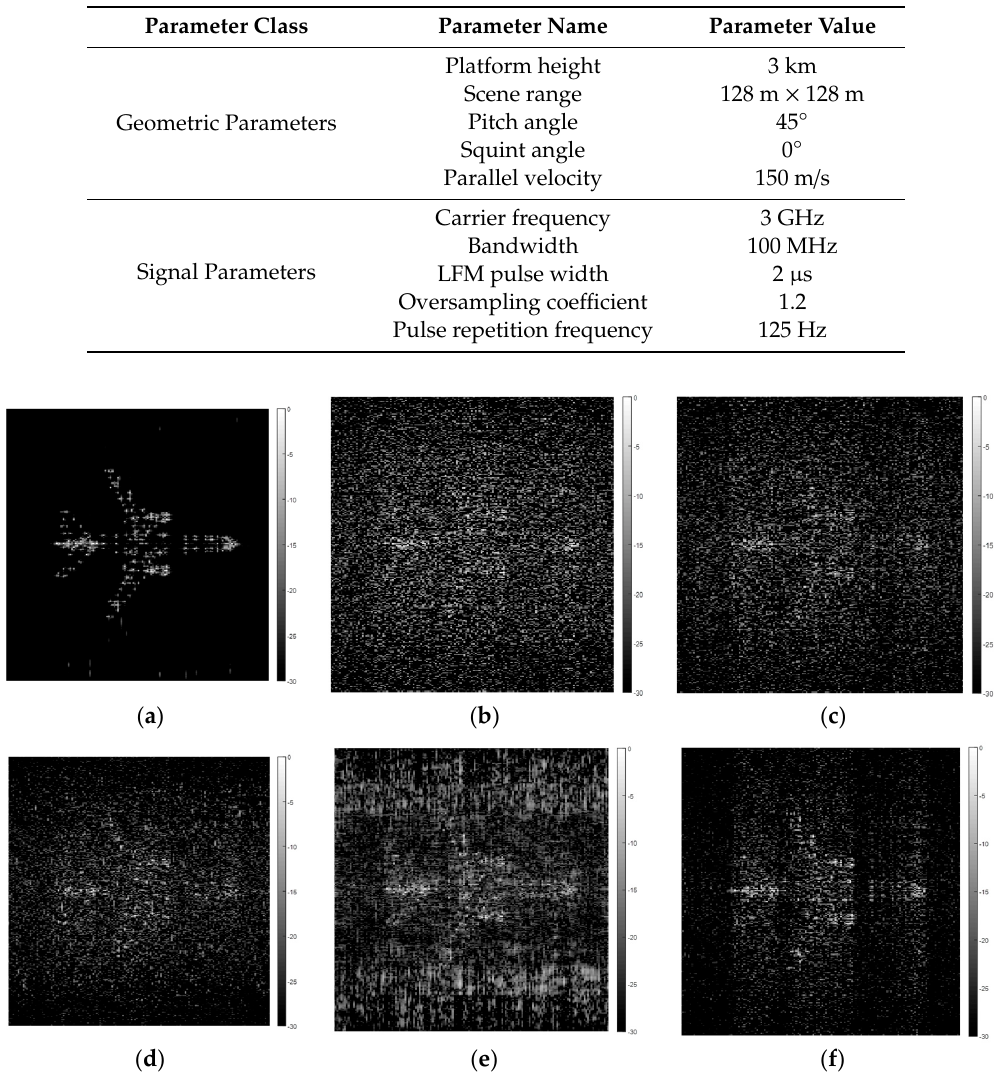
Figure 10. Range-azimuth imaging based on different WBNI suppression algorithms. ( a ) Original; ( b ) contaminated; ( c ) BPDN; ( d ) ACS; ( e ) BSBL; and ( f ) DDSE. Table 5. Main parameters for range-azimuth imaging simulations.